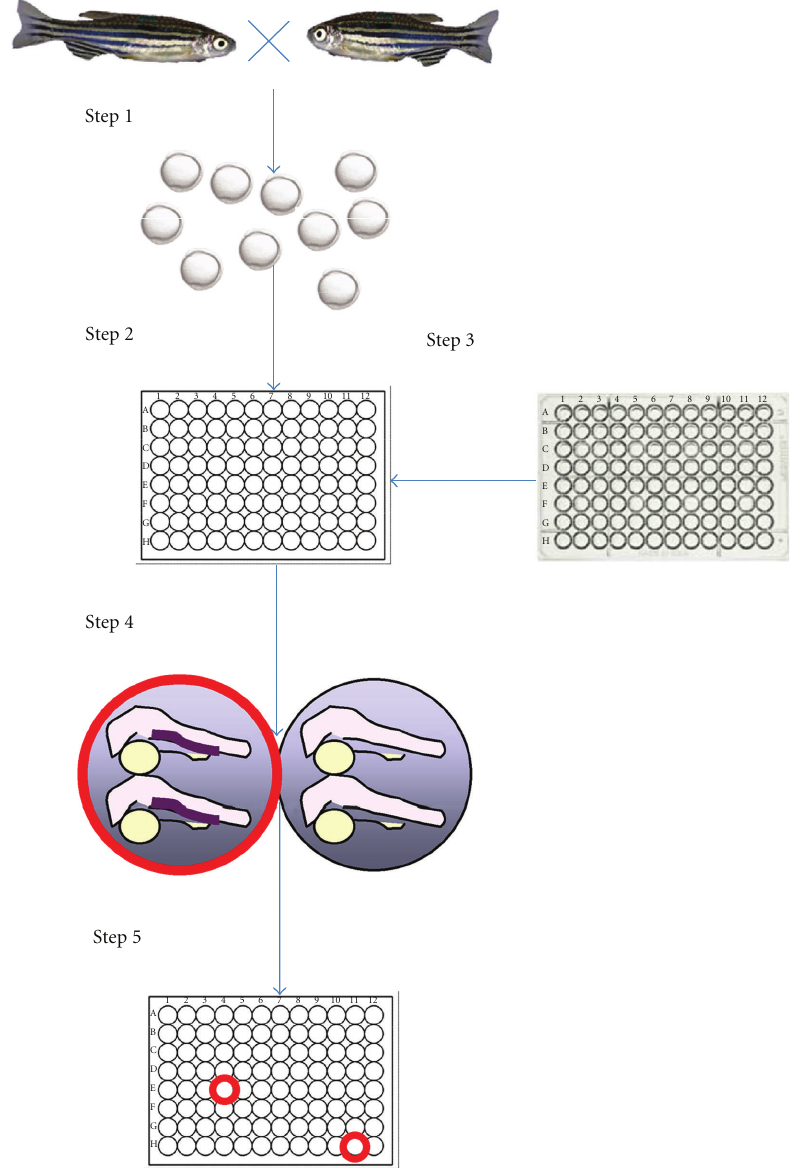
Figure 1: Chemical screening using zebrafish embryos. Step 1—Wild-type, reporter, or mutant zebrafish are crossed to obtain embryos. Step 2—Once reaching an investigator-specified developmental stage (usually between 0–5 days after fertilization), embryos are arrayed into multi-well plates either manually or by automation. Step 3—Compounds from a chemical library are added into the wells containing the embryos using a multichannel pipette or a pin-transfer device. Step 4—After reaching the developmental stage for phenotype manifestation, which is usually within hours to a couple of days after the compound treatment, embryos may be subjected to staining procedures, reporter, or functional assays to detect chemical-induced phenotypes or reversal of genetic phenotypes. The images shown here depict di ff erential hematopoietic gene expression between the compound-treated (red circle) and vehicle-treated (black circle) embryos as detected by RNA in situ hybridization. Step 5— In vivo phenotypes can be detected by visual inspection or by automated imaging and recording. Thus, the whole screening procedure, once optimized, may be automated for high-throughput experimentation and finished within a few days. In addition, a wide range of phenotypes may be detected in vivo